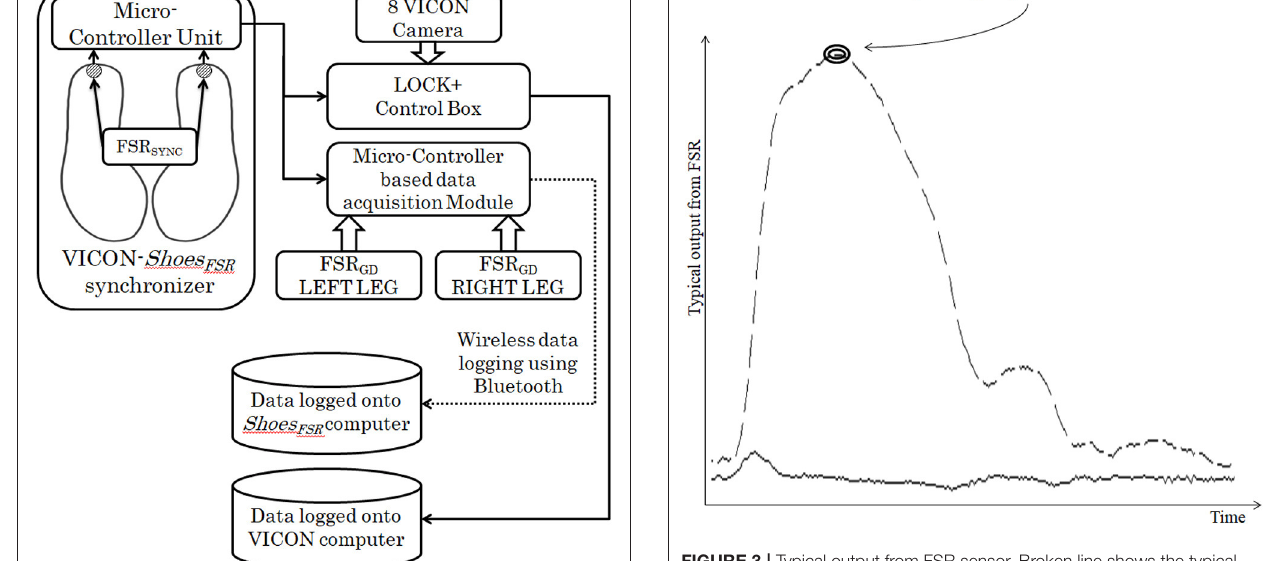
FIGURE 3 | Typical output from FSR sensor. Broken line shows the typical output from FSR GD sensor for one gait cycle; Solid line (lower continuous line) shows the computed successive difference in FSR output; “SI” stands for Symmetry